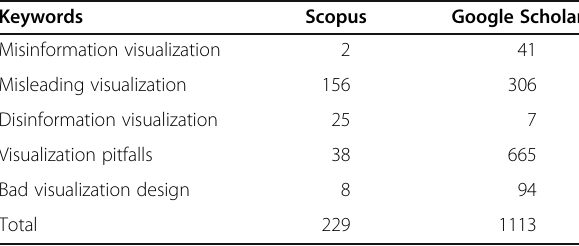
Table 1 Data collection results from Google Scholar and Scopus indexing